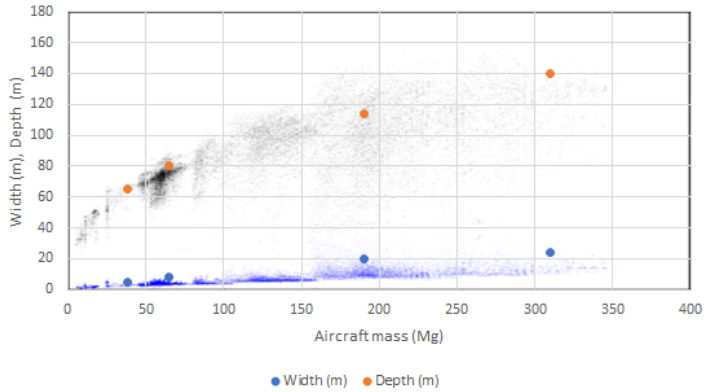
Figure 2. Contraildepth andwidthafter sinkingfollowingformation, computedforBAe 146( s a = 34.1 m, M a = 38.1 Mg), and sample large, medium, and small aircraft (all symbols), with parameters obtained from reference [20], juxtaposed over the scatter plot where each dot represents an aircraft flying over the North Atlantic during 6–9 June 2006.